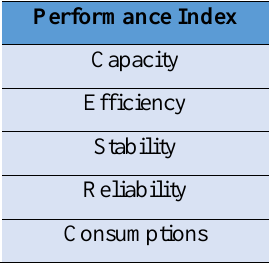
Table 1. Performance index of a multicast cloud computing.